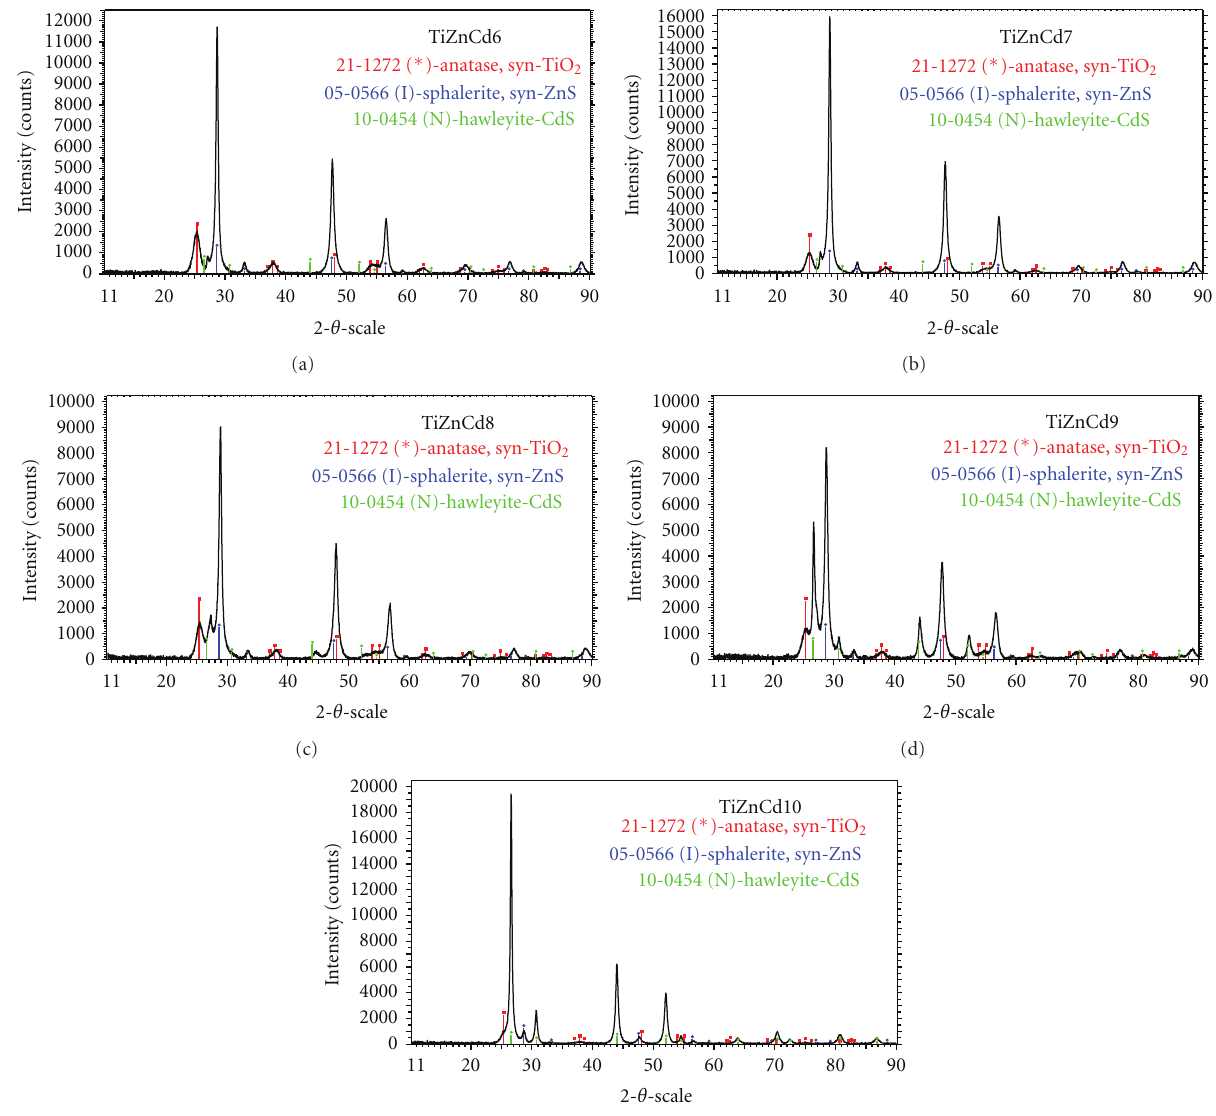
Figure 5: XRD patterns of sample (a) TiZnCd6, (b) TiZnCd7, (c) TiZnCd8, (d) TiZnCd9, and (e) TiZnCd10.